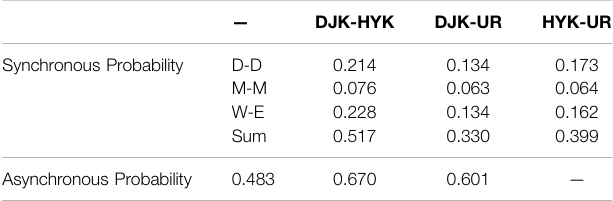
TABLE 6 | Encounter probability of bivariate combination types. — DJK-HYK HYK-UR Synchronous Probability D-D